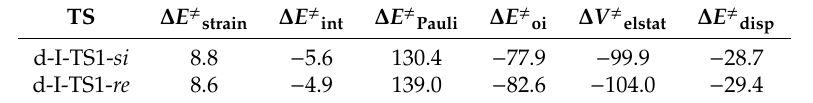
Table 2. Activation strain model (ASM) 1 analysis and energy decomposition analysis (EDA) 2 for the catalytic cyanation reaction of olefins via d-I-TS1- si and d-I-TS1- re . The energies are given in kcal mol − 1 . TS Δ E ≠strain Δ E ≠int Δ E ≠Pauli Δ E ≠oi Δ V ≠elstat Δ E ≠disp d-I-TS1- si 8.8 −5.6 130.4 −77.9 −99.9 −28.7 d-I-TS1- re 8.6 −4.9 139.0 −82.6 −104.0 −29.4